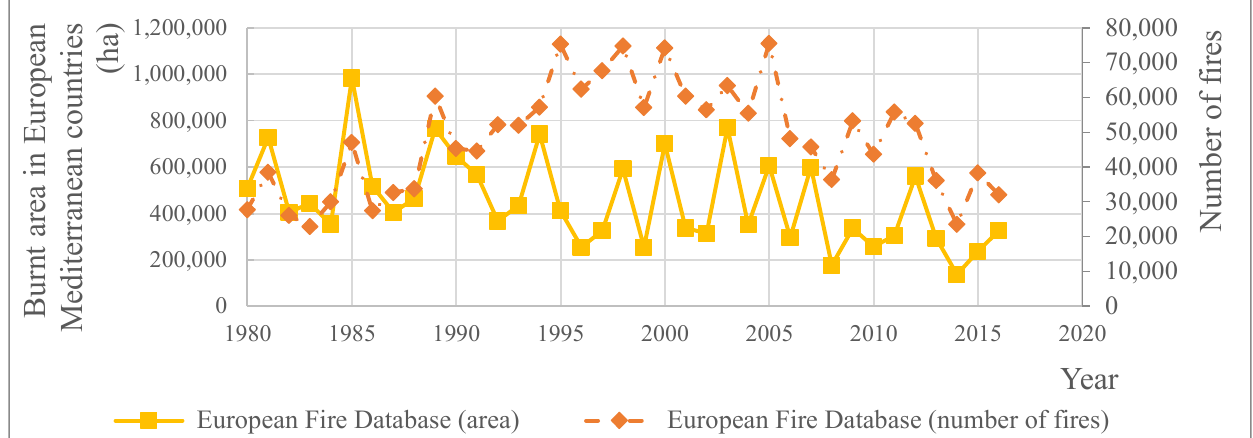
Figure 3. The evolution of wildfires in European Mediterranean countries (1980–2016).